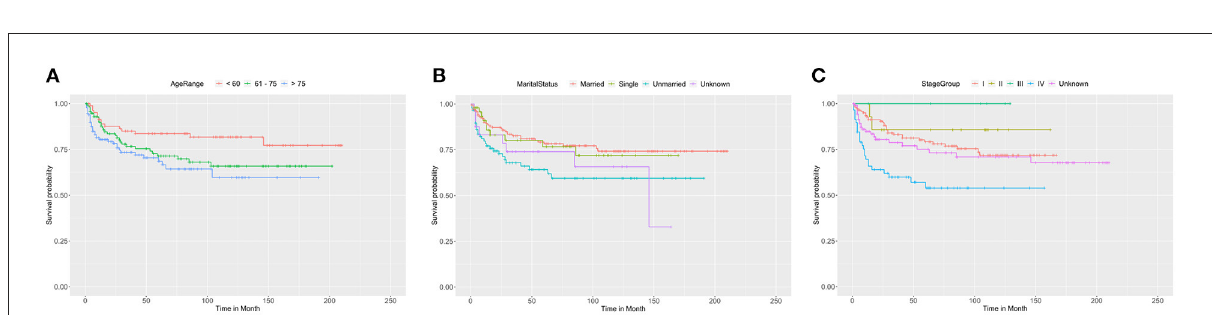
FIGURE3 The Kaplan-Meier survival curve of CSS in patients with orbital DLBCL stratifed by (A) age at diagnosis, (B) marital status, (C) stage. It was revealed that old age, unmarried status, and stage IV were associated with worse CSS compared by log-rank test. In (A) , > 75 vs. < 60 years ( p = 0.007); 60-75 vs < 60 years ( p = 0.074). In (B) , Unmarried vs. Married ( p = 0.006); Single vs. Married ( p = 0.787); Unknown vs. Married ( p = 0.161). In (C) , stage IV vs. stage I ( p < 0.001); stage II vs. stage I ( p = 0.460); stage III vs. stage I ( p = 0.994); unknown vs. stage I ( p =